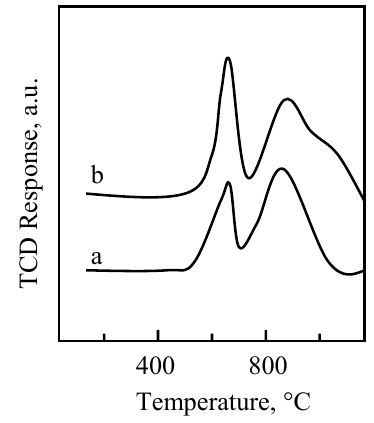
re 4 . TPR spectra of bulk MoO mmercially